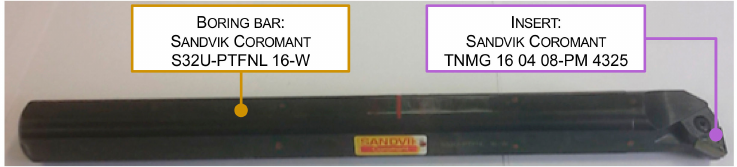
Figure 9. Original boring bar.